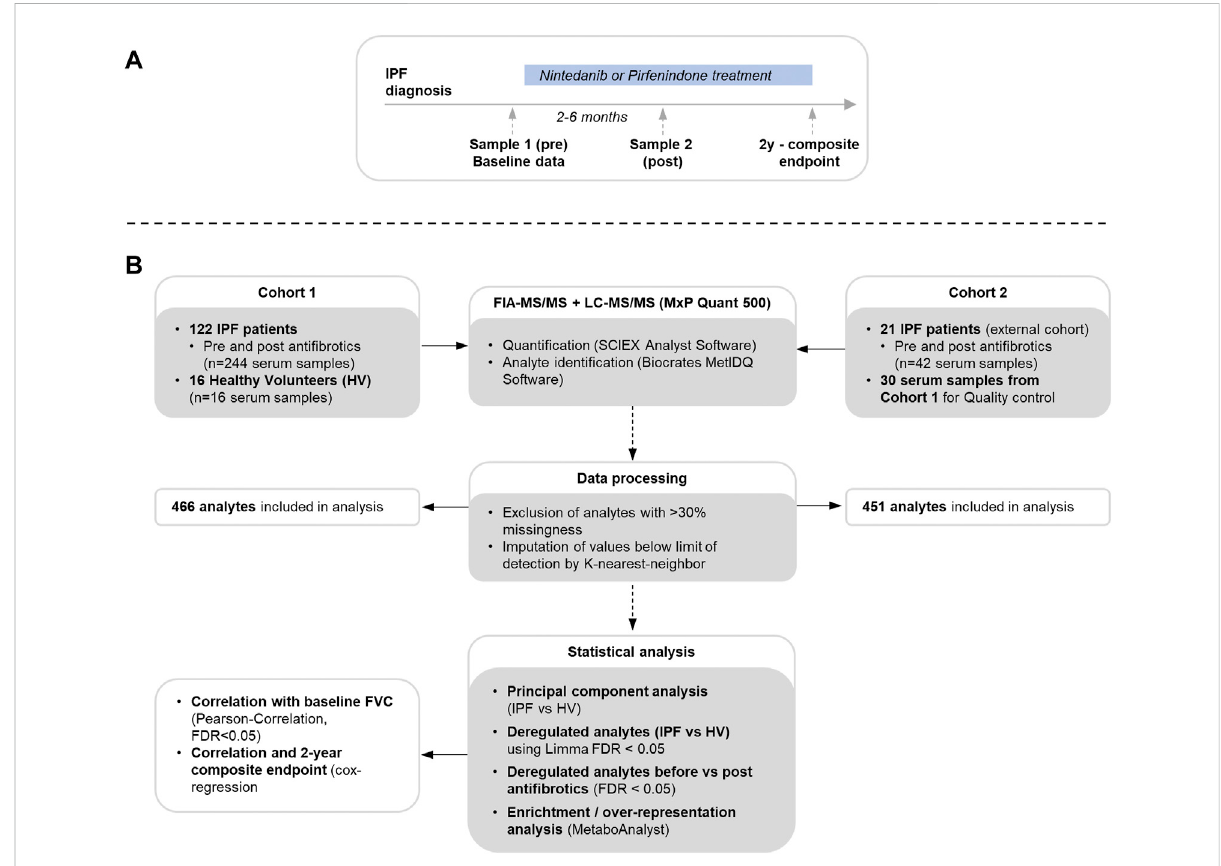
FIGURE 1 Flowchart for sample and clinical data acquisition (A) and metabolome measurement, data processing and statistical analysis (B)